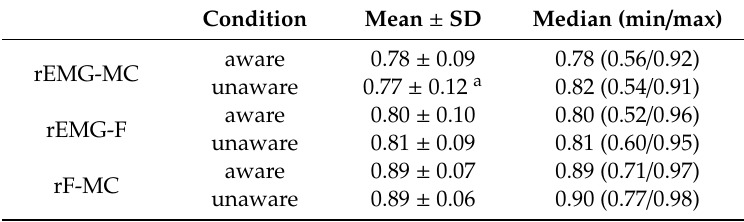
Table 3. Maximum values of coe ffi cients r estimated with cross-correlation between EMG, MC neck and neck-muscle load F; mean ± SD and median (min /